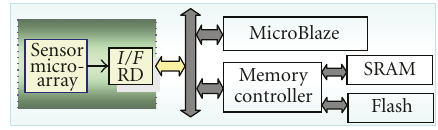
Figure 2: Single core data analysis